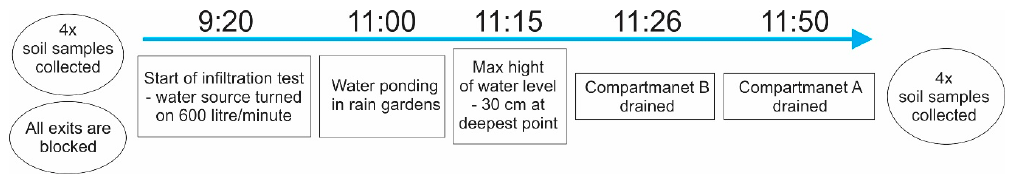
Figure 6. Description of the full-scale infiltration test at Bryggen on 6th of September 2017.